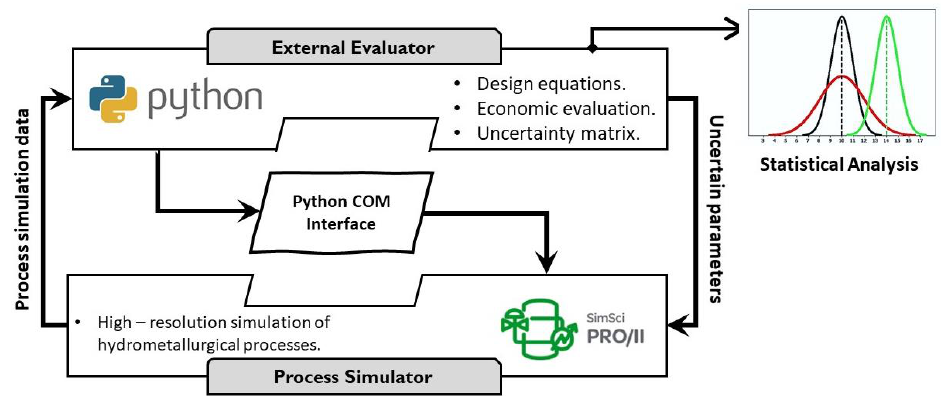
Figure 3. Framework for the stochastic analysis of gold recovery processes including the process simulator PRO/II and a Python environment connected through the Python–Component Object Model (COM) interface.